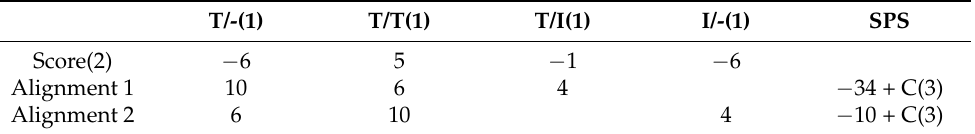
Table 1. Sum-of-pairs scores for Alignment 1 (Figure 1) and an alternative Alignment 2 with “T-” occupying sites 20 and 21 in N. procyonoides. Only sites 20 and 21 in Figure 1 are considered. T/-(1) T/T(1) T/I(1) I/-(1) SPS Score(2) − 6 5 − 1 − 6 Alignment 1 10 6 4 − 34 + C(3) Alignment 2 6 10 4 − 10 +